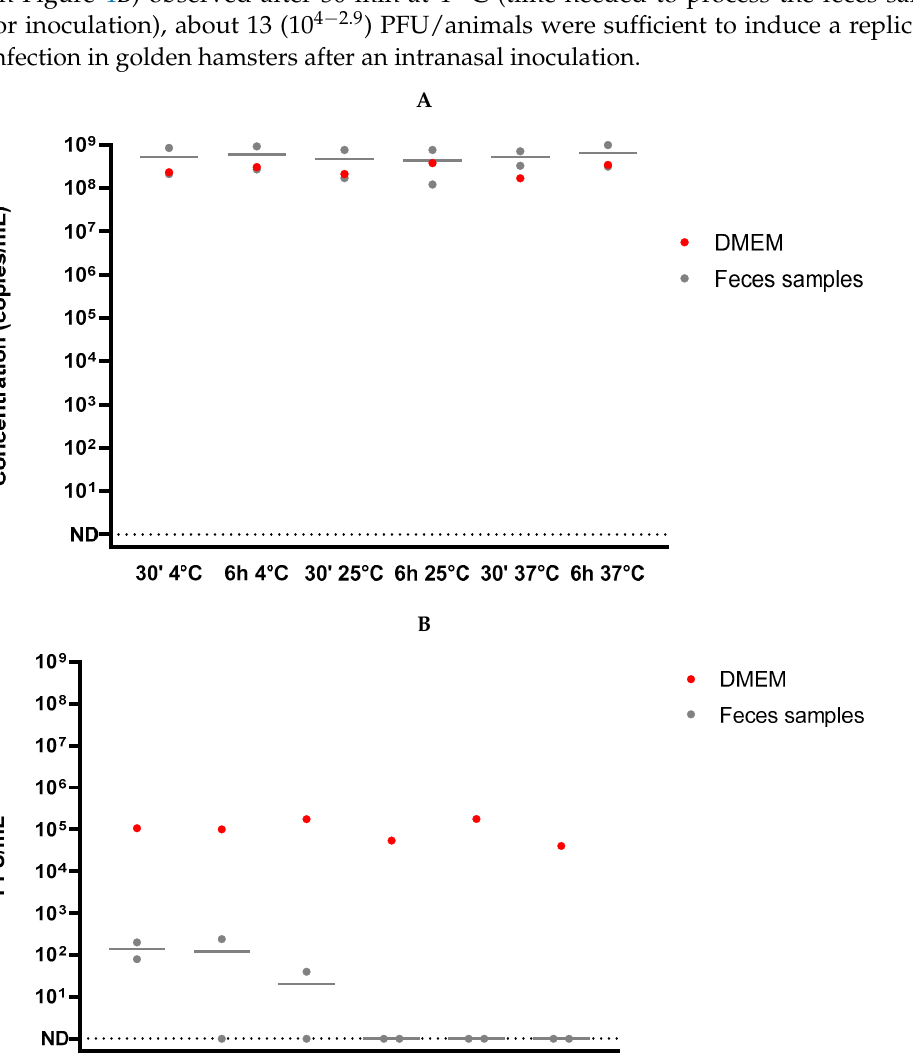
strated: clinical evidence with the report of numerous infected patients suffering from gastroenteritis symptoms [2,3], significant fecal excretion of viral genomes in feces [10],